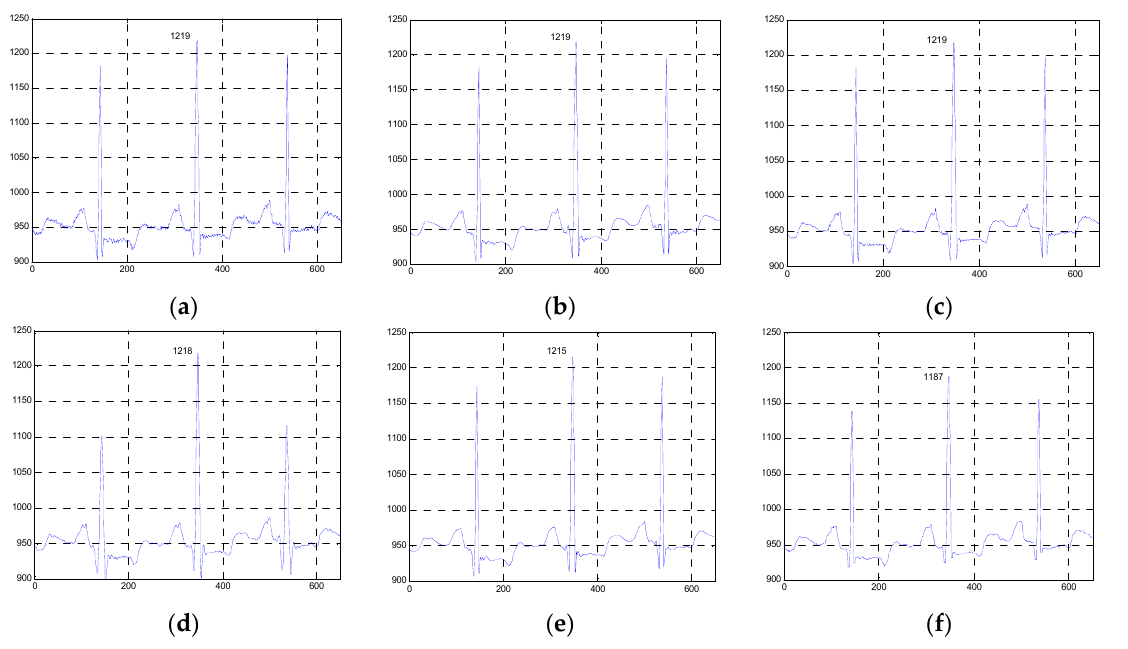
Figure 11. Comparison of the denoised results for the ESMD-NLM, NLM, EEMD, VMD and MED methods operating on the sel100m.dat in the second group of clinical ECG signals. ( a ) The clinical ECG signal, ( b ) the ESMD-NLM method, ( c ) the NLM method, ( d ) the EEMD method, ( e ) the VMD method, ( f ) the MED filter.